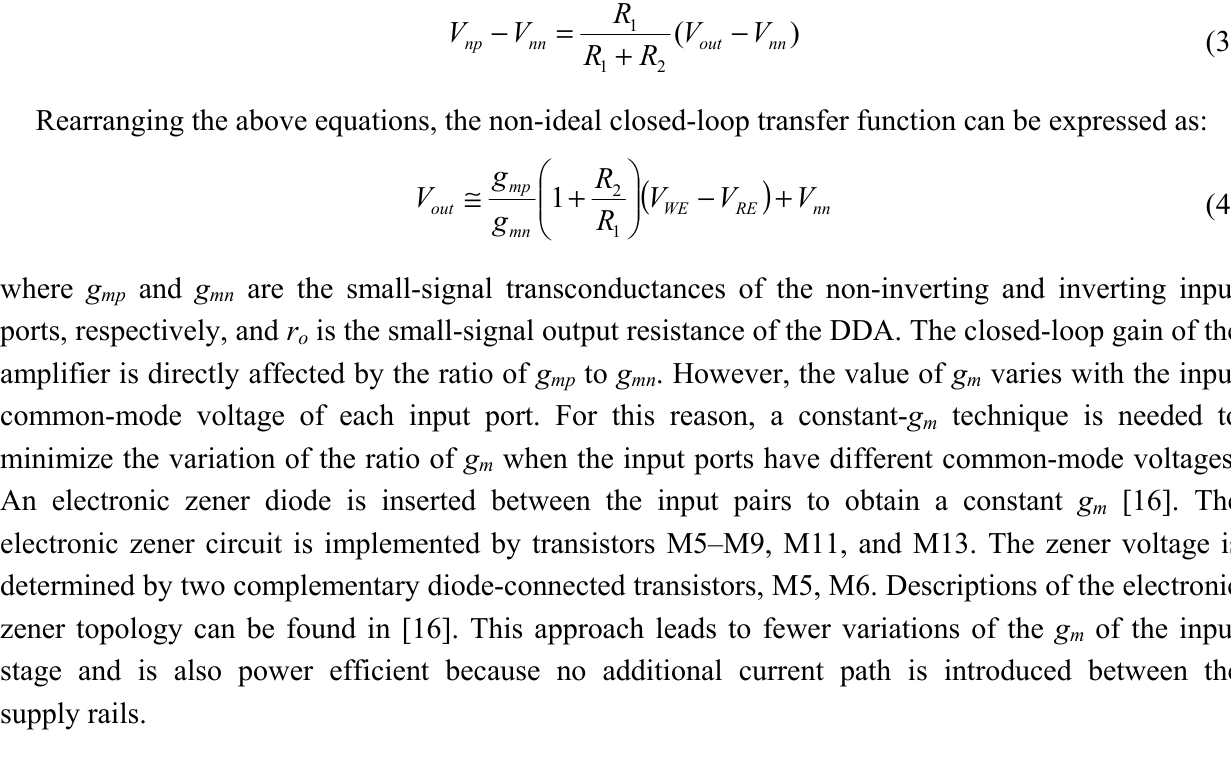
Figure 3. Schematic of the